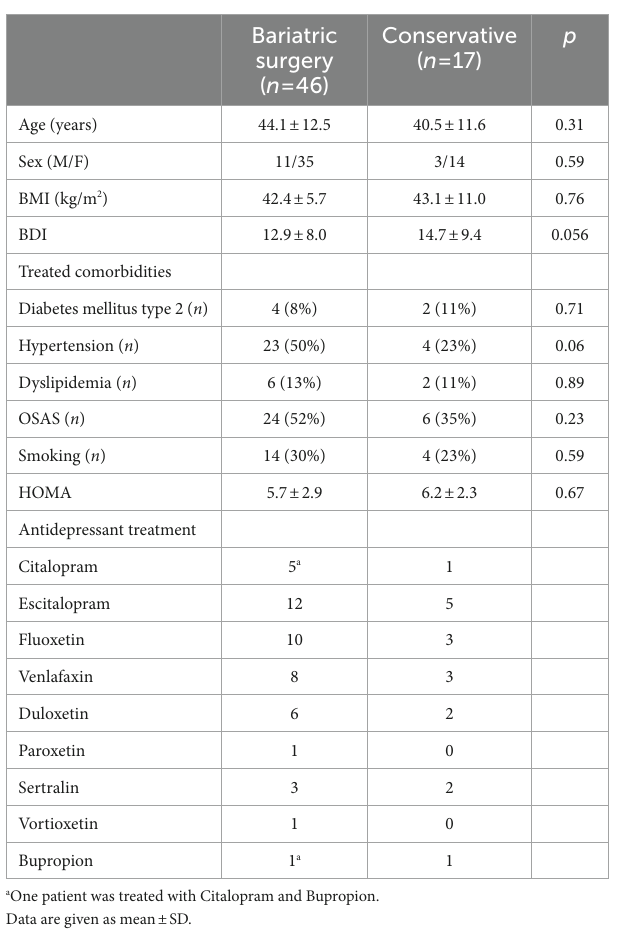
TABLE 1 Baseline characteristics of participants, undergoing bariatric surgery ( n = 46), and on conservative treatment ( n = 17).